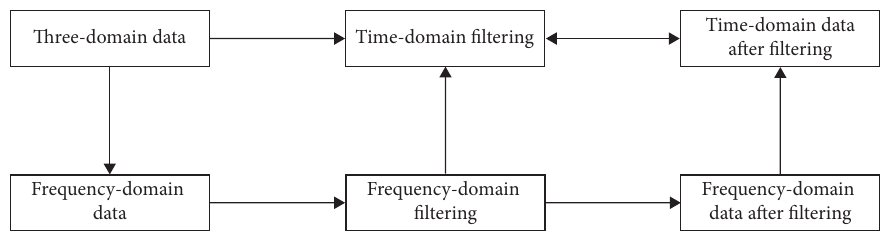
Figure 3: Basic principle of time-domain filter.